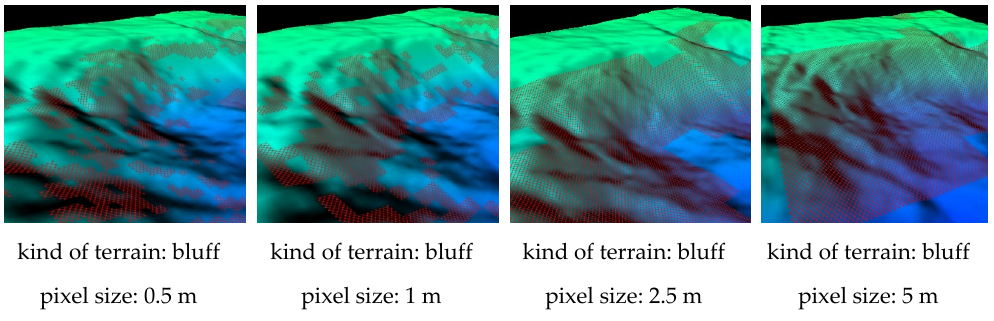
Figure 15. 3D visualization of the bluff terrain with indicated impassable areas depending on the pixel size.